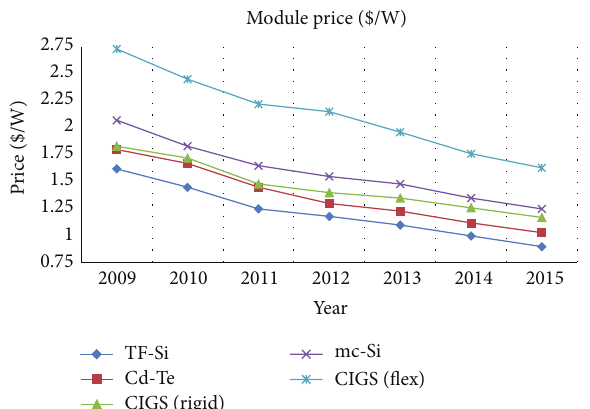
Figure 4: Estimated price development for different PV technolo- gies [13].